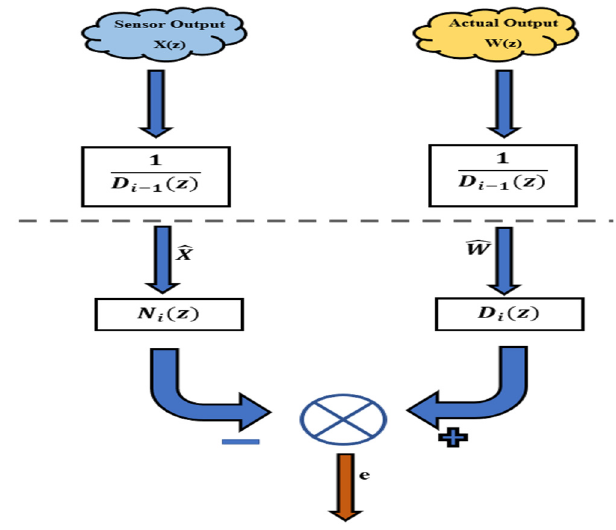
Figure 2. Iterative procedure for minimizing error.